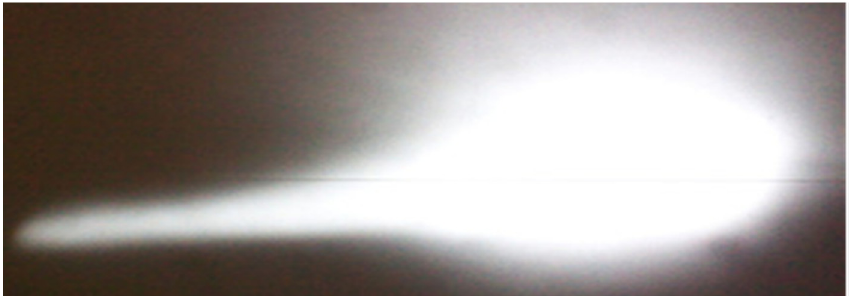
Figure 4. Beam profile image measured by a profile monitor.